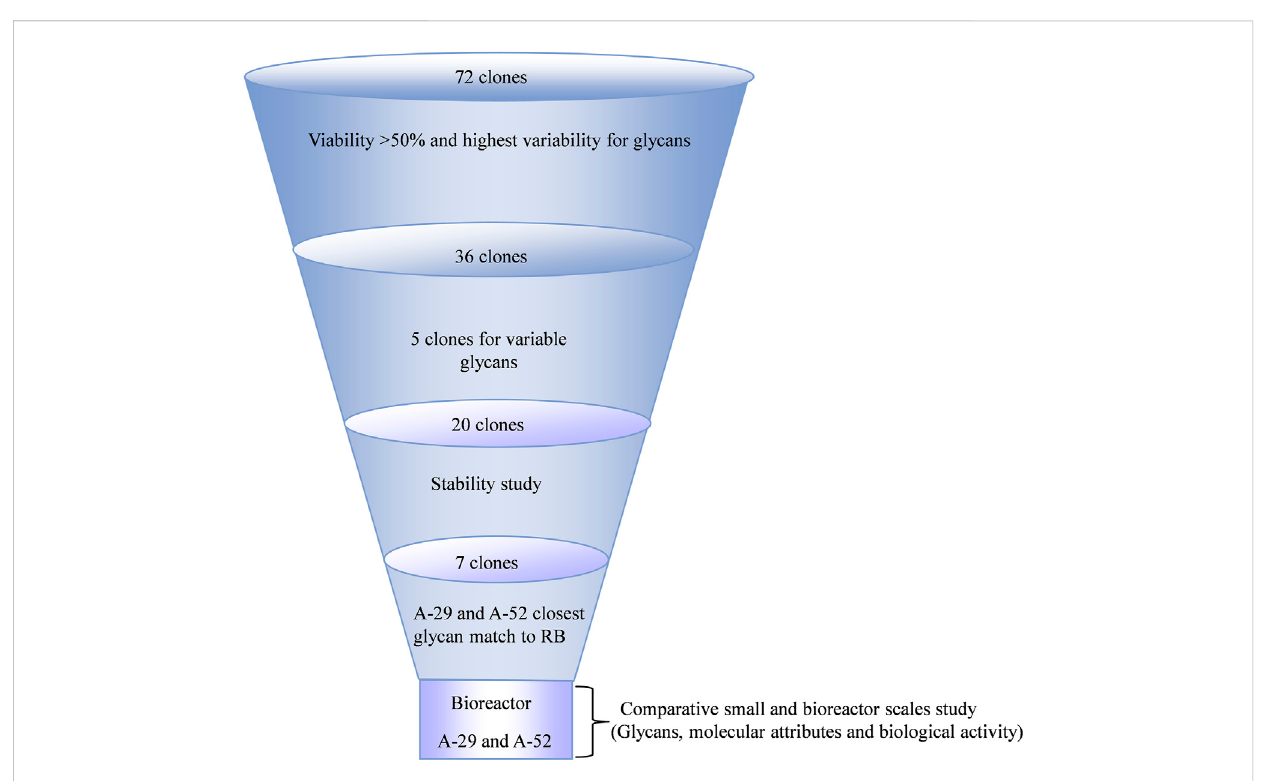
FIGURE 5 Selection and work fl ow of the clone selection.